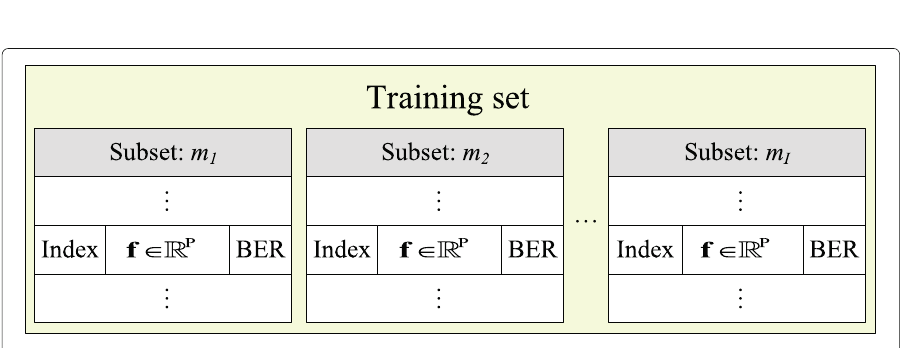
Fig. 6 Structure of the training